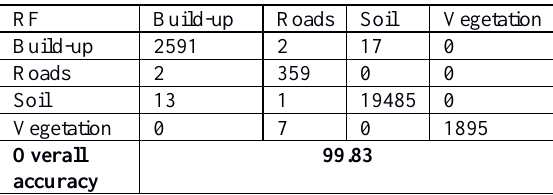
Table 4. Accuracy of predicted materials by a combination of SVM, ML and RF classification